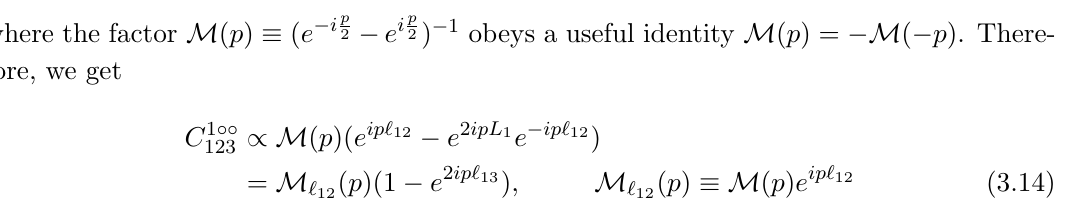
( p ) = ( p ). M (cid:0)M (cid:0)